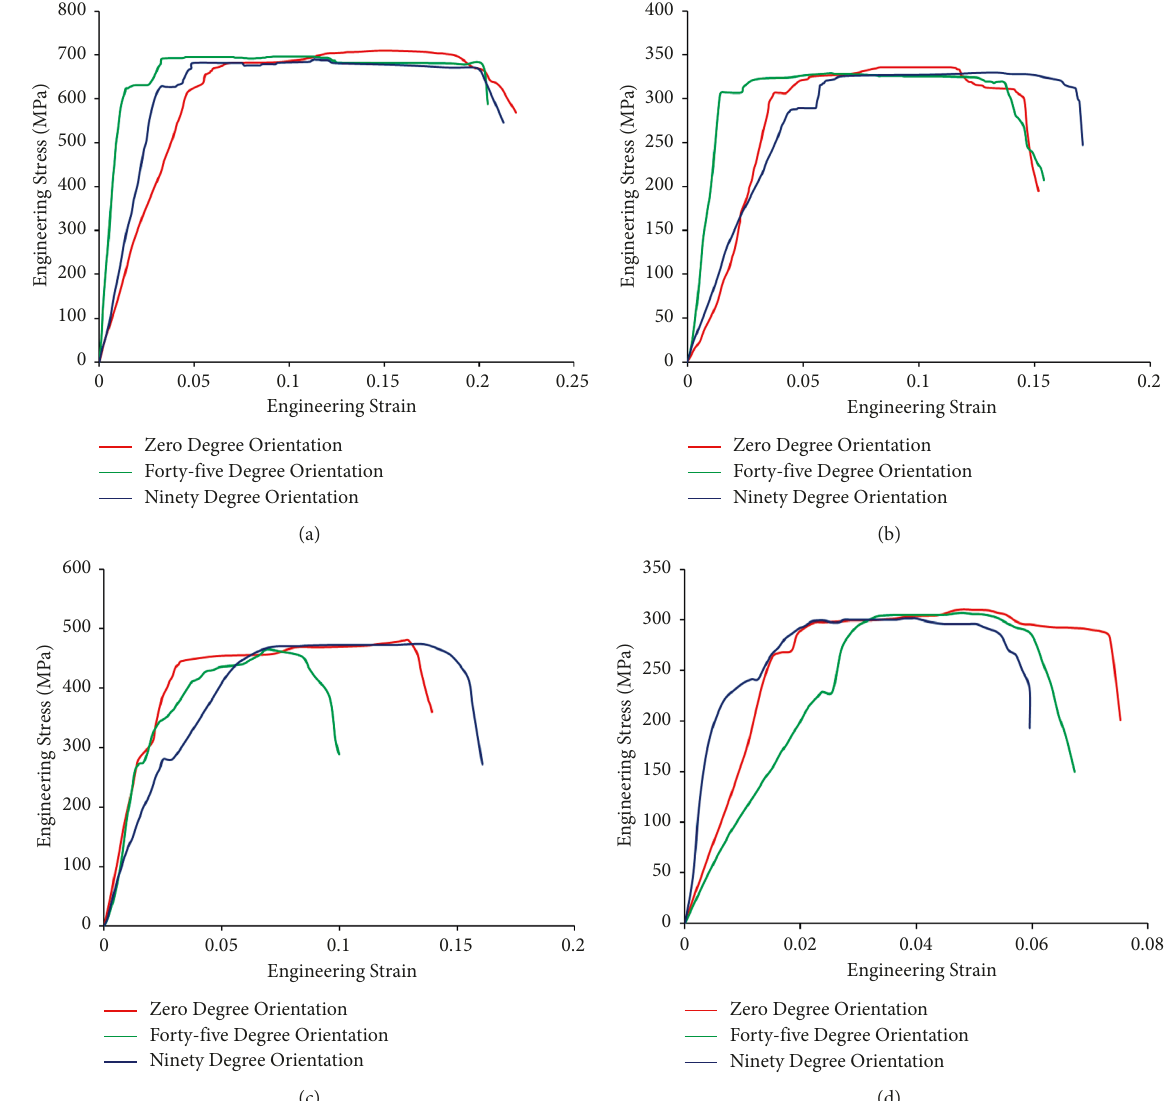
Figure 6: Engineering stress-strain plots of GSS (a), AS (b), GPG (c), and APA